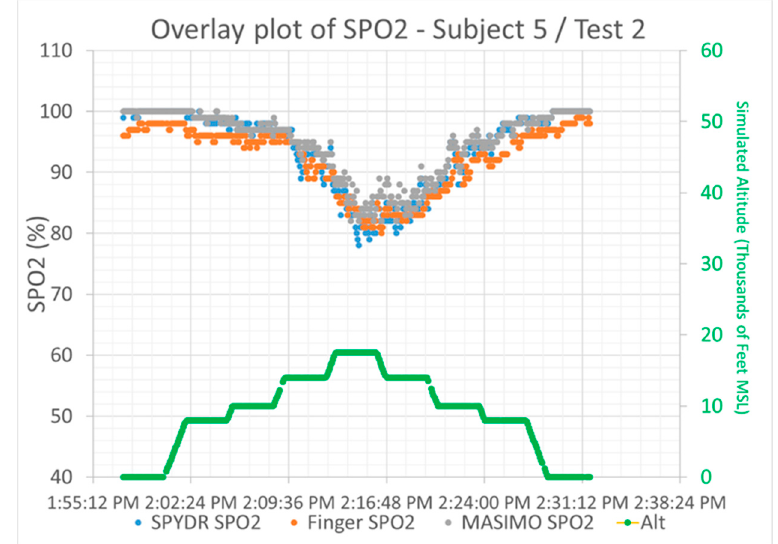
Figure 3. Exemplary overlay plot showing SpO 2 output from SPYDR (blue), Nonin finger oximeter (orange), and Masimo forehead sensor (grey) show high degree of correlation between all sensors. Simulated altitude is shown as solid line at bottom (green), and all sensors performed as expected to reduced oxygen levels associated with changes in simulated altitude.